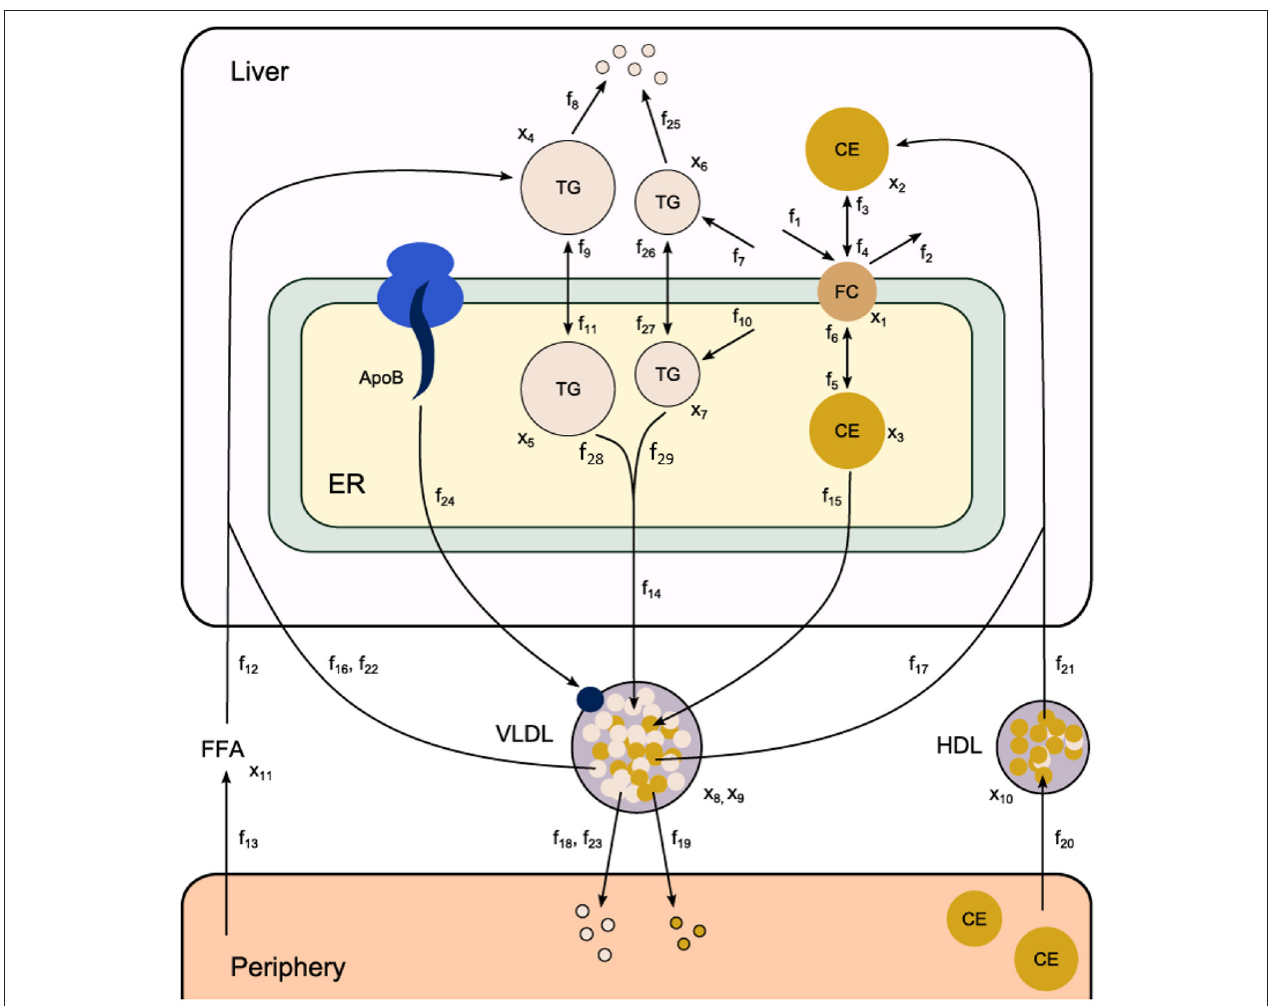
FIGURE 1 | Computational model of hepatic lipid and plasma lipoprotein metabolism (HepaLip2), under fasting conditions. The HepaLip2 model is composed of three compartments representing the liver cytosol, liver endoplasmic reticulum, and blood plasma. The liver compartment includes reactions comprising the production, utilization, and storage of triglycerides and cholesterols, and the mobilization of these metabolites to the endoplasmic reticulum, where they are incorporated into nascent VLDL particles. The VLDL particles are secreted in the plasma compartment where they serve as energy source for peripheral tissues. Remnant particles are taken up and cleared by the liver. The model furthermore includes the hepatic uptake of free fatty acids as well as HDL-mediated reverse cholesterol transport. The model is composed of 11 differential equations (and 11 corresponding state variables x ), 29 fluxes f and 22 (unknown) parameters. ApoB, apolipoprotein B; CE, cholesterylester; ER, endoplasmic reticulum; FFA, free fatty acid; FC, free cholesterol; HDL, high density lipoprotein; TG, triglyceride; VLDL, very low density lipoprotein.